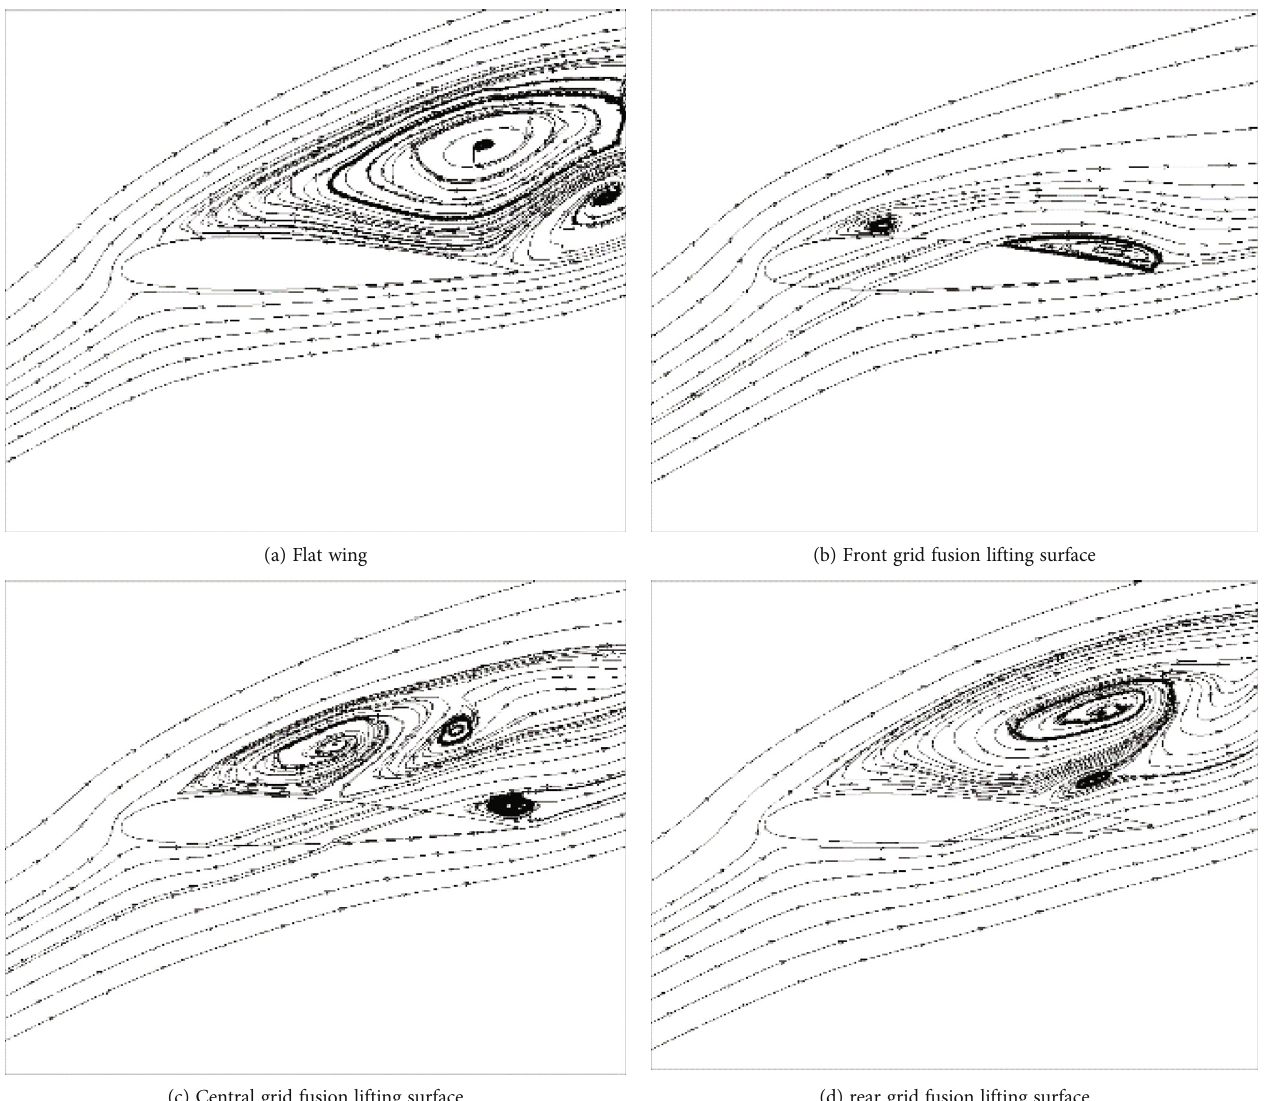
Figure 16: Fluid streamline diagrams of grid fusion lifting surface with di ff erent grid Position ( Ma = 0 : 6 α = 28 ° z / b = 0 : 75